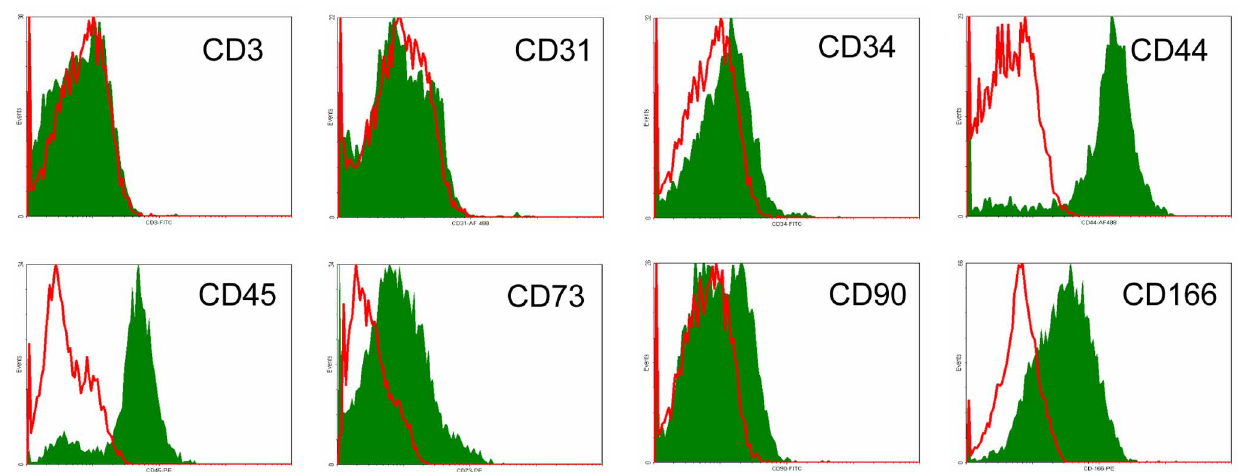
Figure 6. MSC phenotyping. MSCs were harvested and analysed with flow cytometry for a panel of MSC-characterizing markers on day 7. Thus, the presented phenotype resembles that of MSCs used in the cocultures. MSCs were negative for CD3, CD31, CD34, and CD90. Positive signals were measured for CD44, CD73, and CD166. Positive as well as negative signals were detected for CD45.